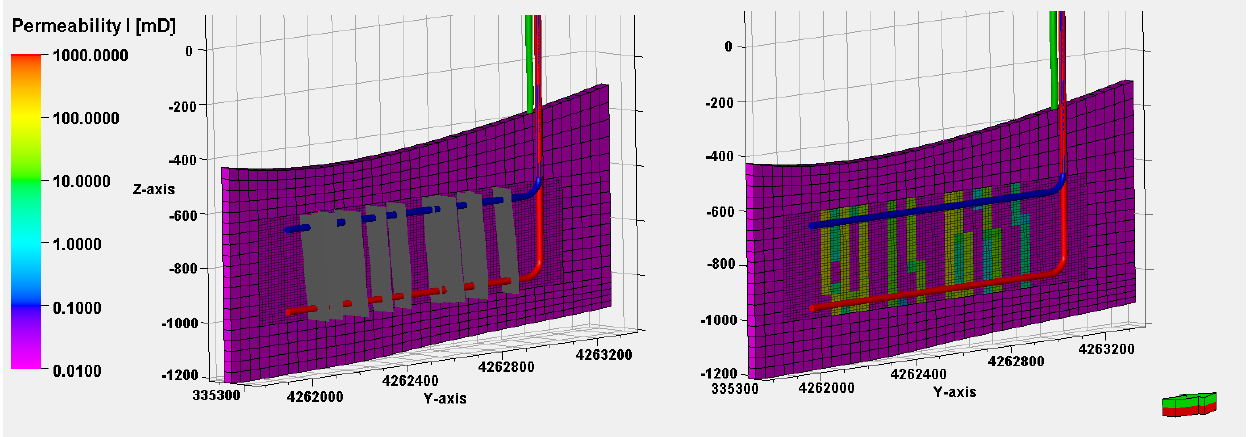
Figure 9. Hydraulic fractures planes located in the model ( left ) and the permeability alteration along the fractures ( right )